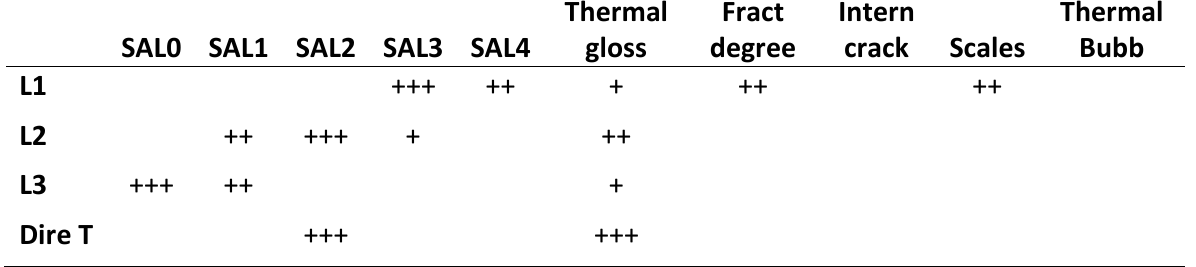
Table 2. Observed comparative patterns of development of heat alterations (SMM flint blanks). Abbreviations: + - low presence or low development of feature; ++ - feature commonly present; +++ - feature present in all cases and highly developed; blank cells indicate absence of feature; Dire T - blanks thrown